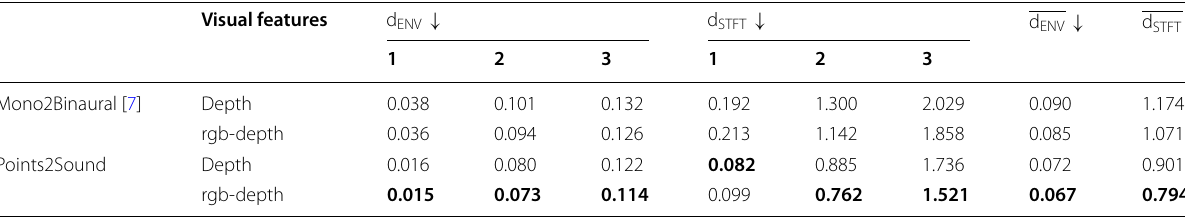
The lowest errors are highlighted using bold font